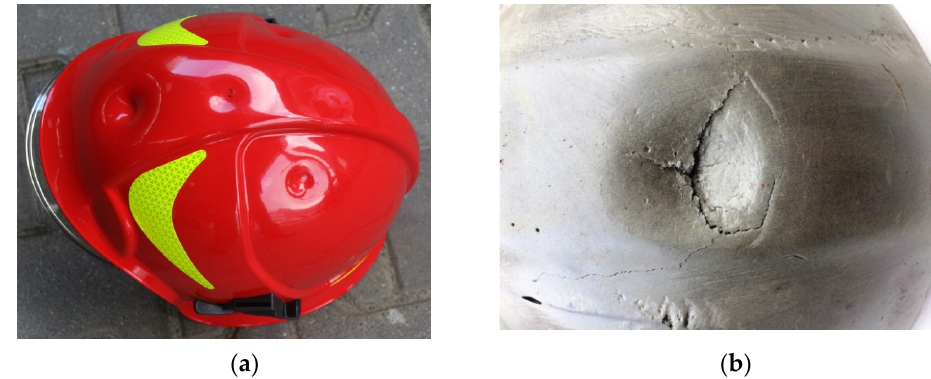
Figure 15. Structural elements of a firefighting helmet after the exposure to the impact loading: ( a ) a helmet shell after an impact test with the energy of 60 J using an impactor with the diameter of 20 mm at the temperature of 140 ◦ C, ( b ) an amortizing liner at the impact point in a helmet exposed to the heat load of 140 ◦